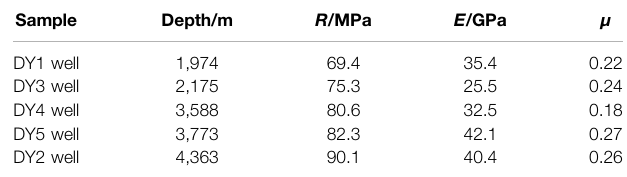
of the Dingshan area,